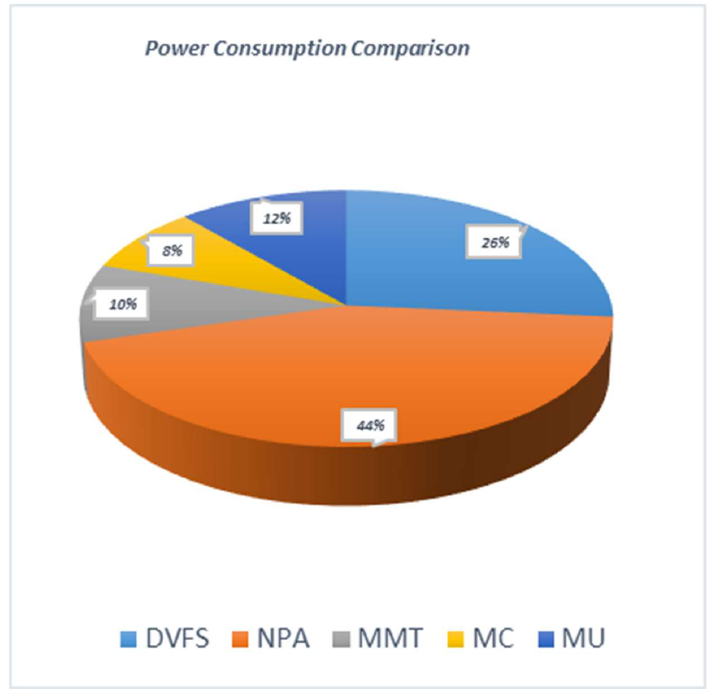
Figure 5. Evaluation of Energy Utilization in the Recommended System.